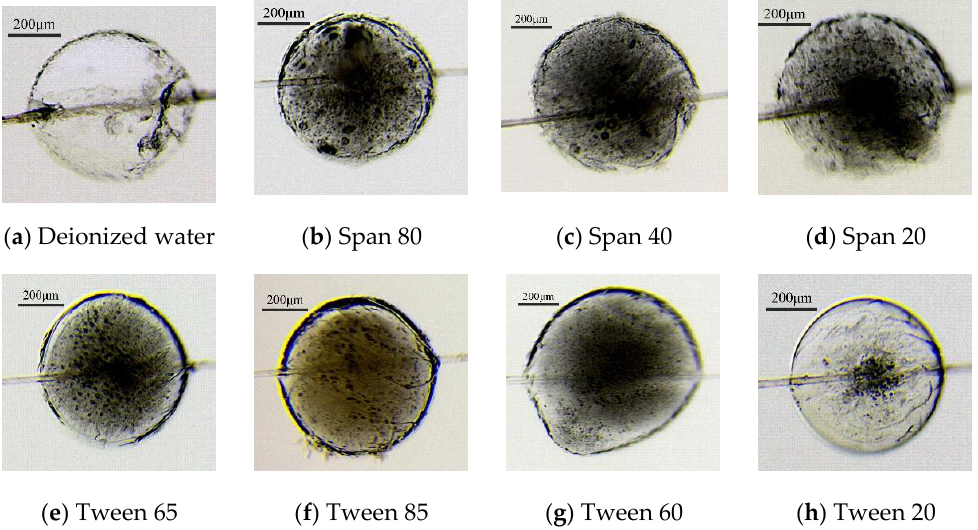
Figure 7. Morphology of cyclopentane hydrate particles in contact with different surfactants (0.1 wt.%).